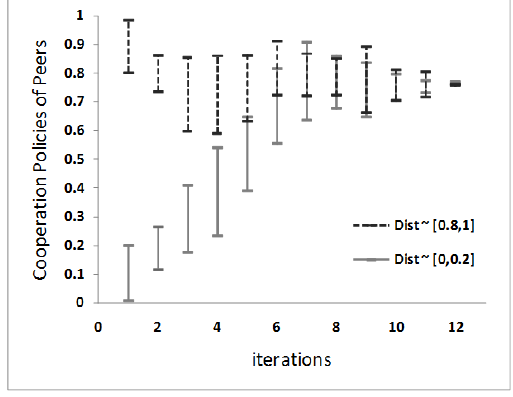
Fig. 11. The consistency of the results in adaption to a specific non-linear cost